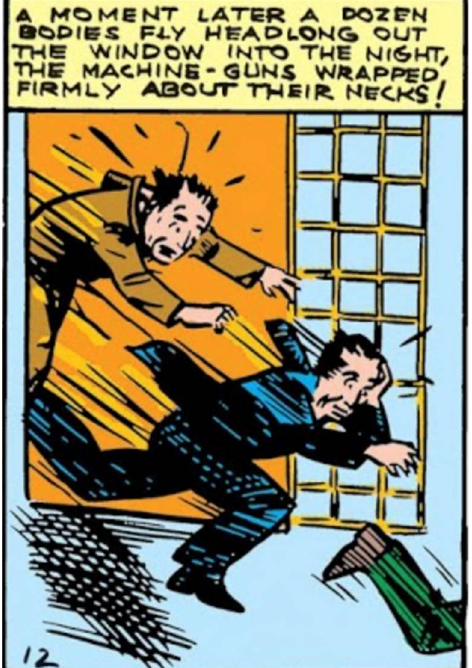
Figure 11. Joe Shuster, Three Armed Guards Running Away from Superman (panel No. 12), 1938. Siegel and Shuster (July 1938), “Superman”, Action Comics #2 (Siegel and Shuster 1938b, p. 23). © DC Comics.